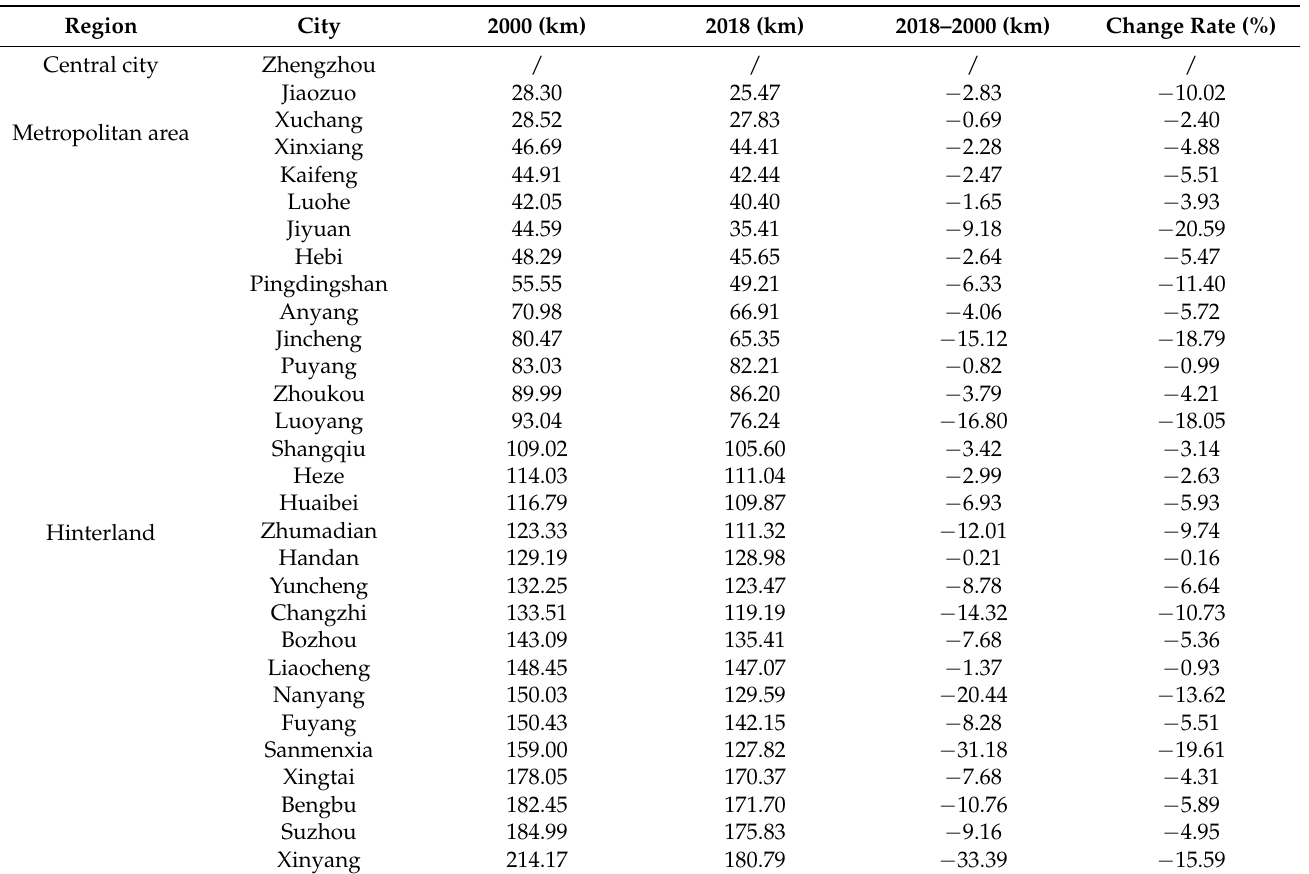
Table 8. ESV spatial transfer radius of cities in the Central Plains Urban Agglomeration from 2000 to 2018. Region City 2000 (km) 2018 (km) Change Rate (%) Central